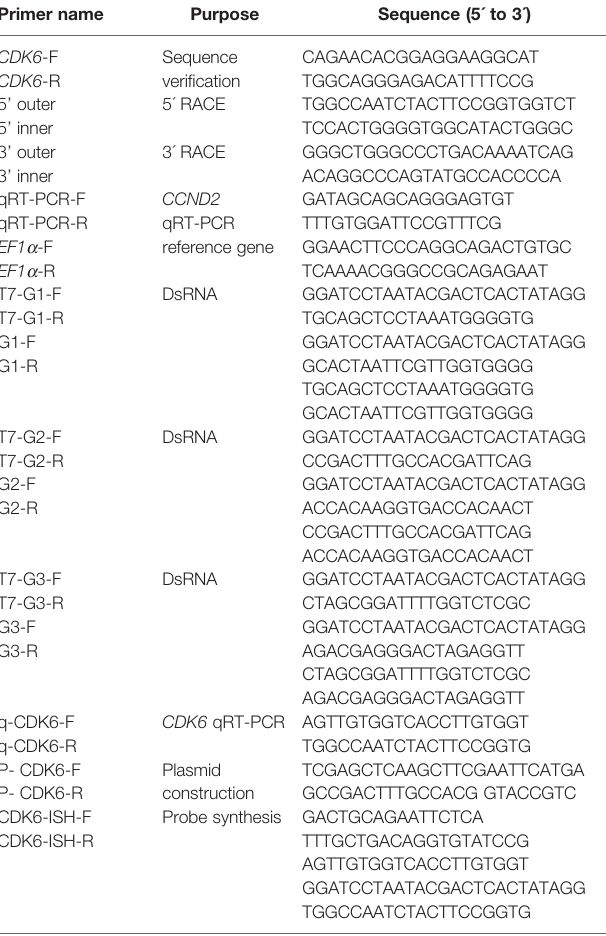
TABLE 1 | Primers used in isolation and characterization of Hc-CDK6 in pearl